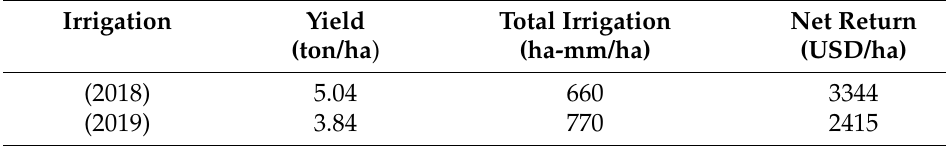
Table 10. The net return of random irrigation.